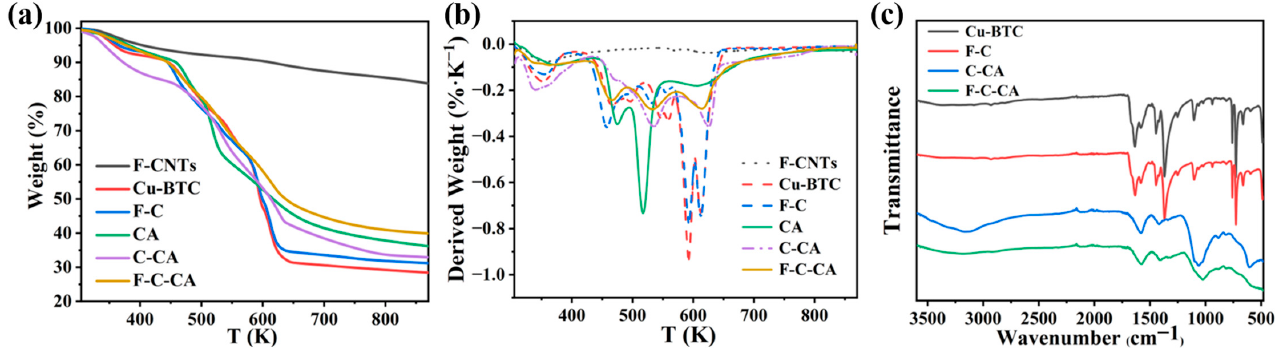
Figure 4. ( a ) TGA curves, ( b ) DTG curves, ( c ) FTIR